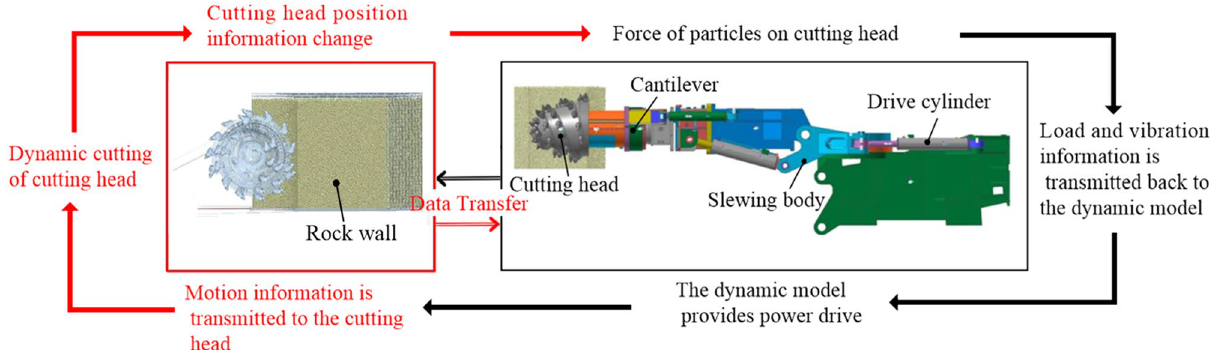
Figure 9. Coupling model and data transfer principle.